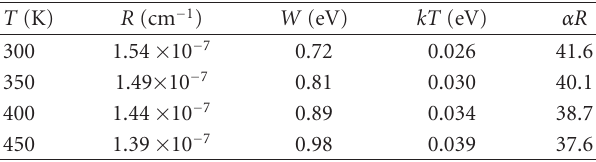
Table 5: Variation of Mott parameters at temperature range of 300–